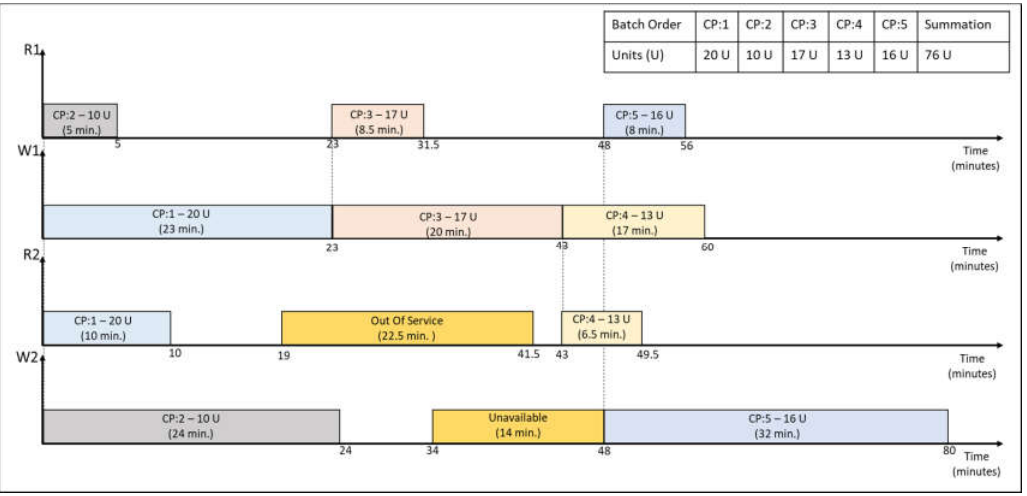
Figure 12. Case-study Gantt Chart. Table 1. Operational Resources Performance.